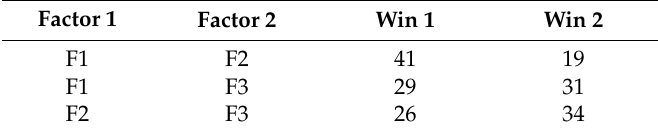
Table 7. Input file of Financial (F) factors preferences in a win-to-loss context.